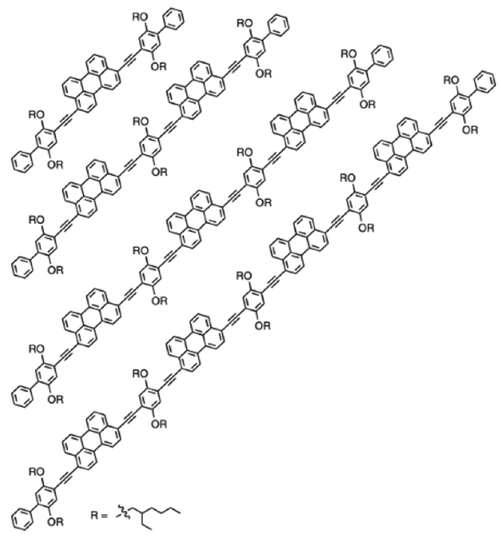
Figure 7. Oligomer structures consisting of one, two, three, and four perylene units, as examined by N. Korovina et al. [78]. Reprinted with a permission from [78], copyright 2020 Nature Research.